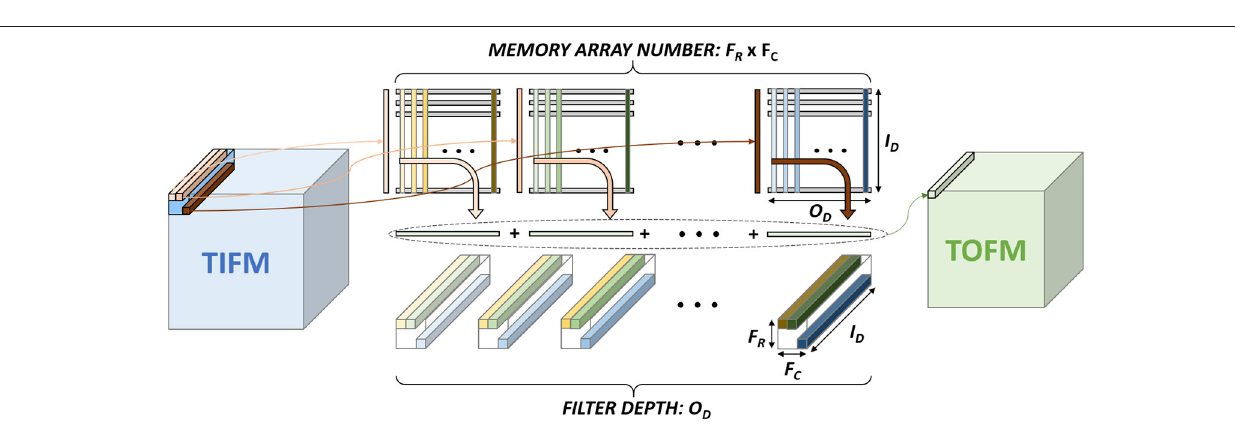
depth ( O D ). The IFM, whose size is F R × F C × I D , is multiplied by each filter and generates the OFM, which size is 1 × 1 × 1. The stride is called as S . Figure 5 shows the CNN mapping method